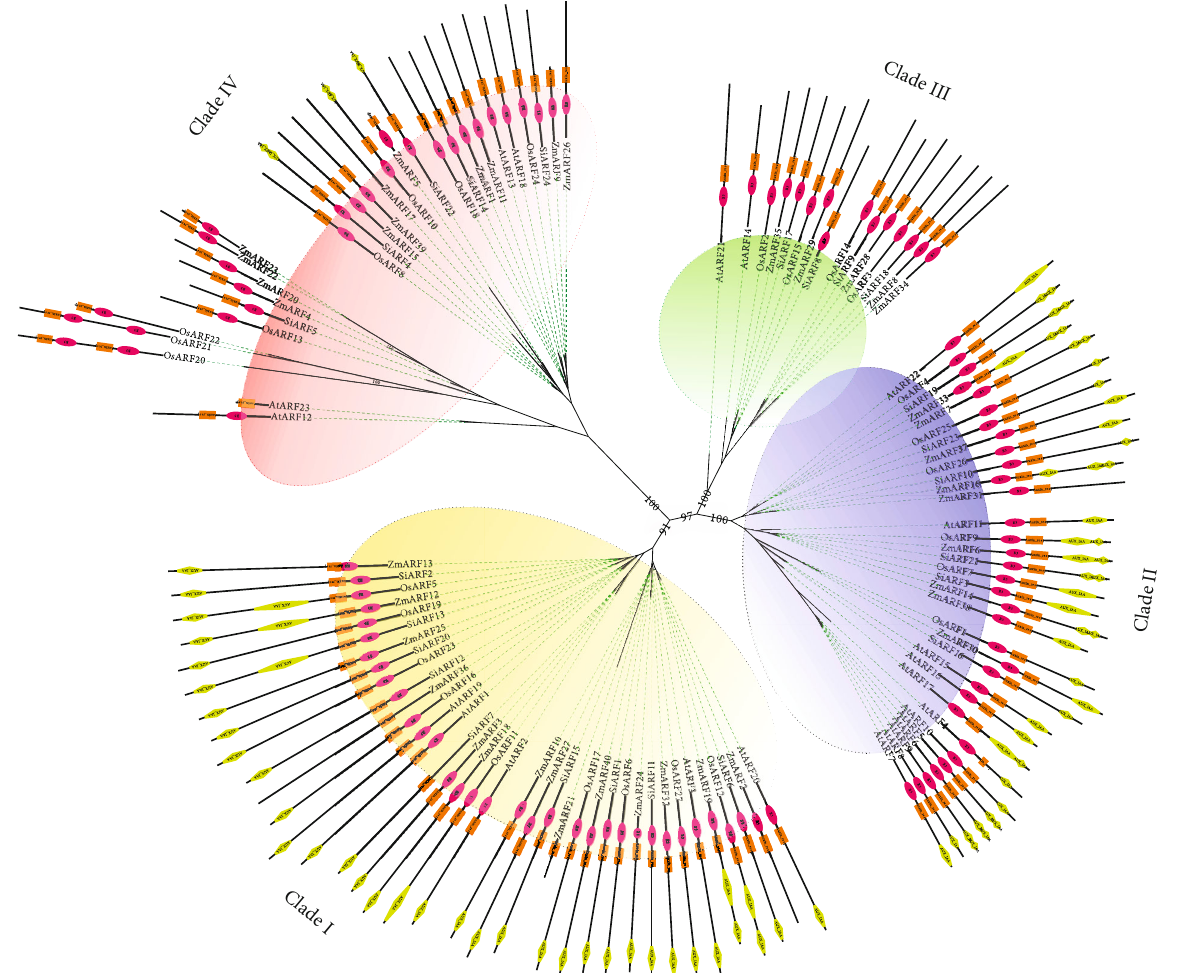
Figure 4: The ML phylogenetic tree constructed by ARF proteins from four plant species. Pre fi xes in the protein names, including Si, Os, Zm, and At, were used as to denote the species they belong to and represent S. italica , O. sativa , Z. mays , and Arabidopsis thaliana , respectively. The phylogenetic tree could be classi fi ed into four clades, and each clade was marked with di ff erent colors. Yellow, blue, green, and red represented clades I to IV, respectively. Protein domain composition of each ARF members was also exhibited. Red diamonds represented B3 domain. Orange squares represented auxin_resp domain, and yellow diamonds indicated Aux/IAA